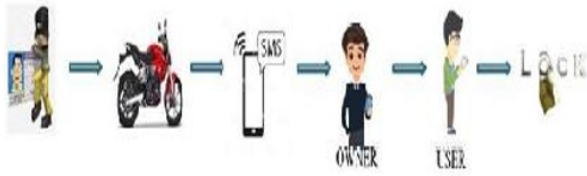
Fig.9. Locking the entire system by using mobile application